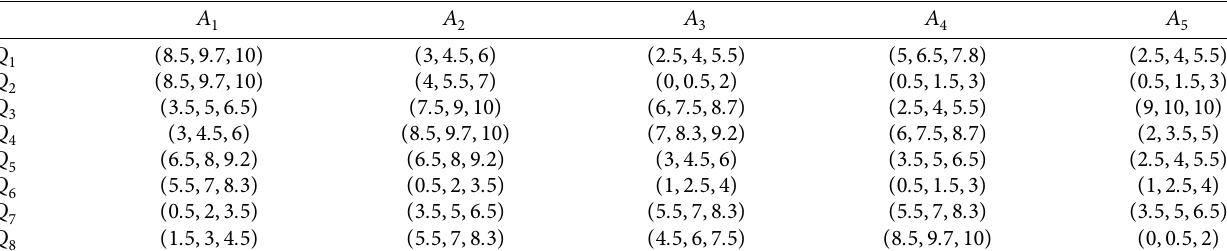
Table 13: The impact of various logistics service capabilities on different service quality indicators: described by fuzzy numbers.